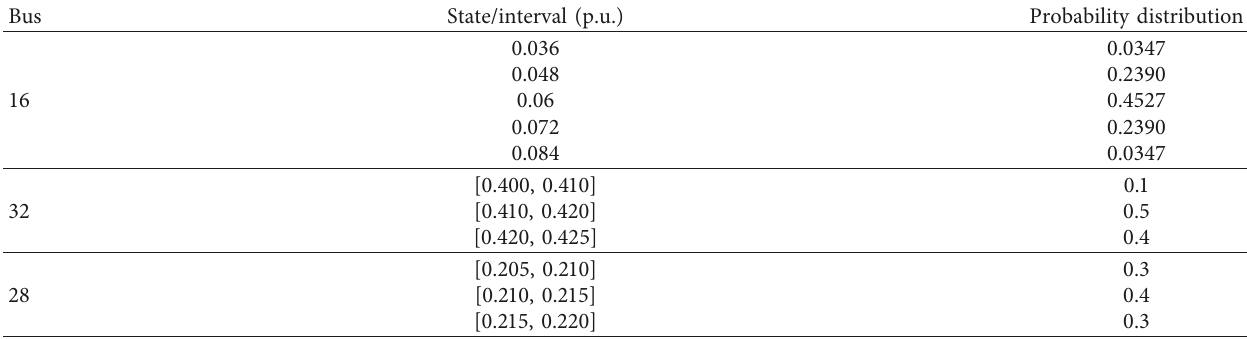
Table 3: The parameters and probability distribution for uncertain loads.